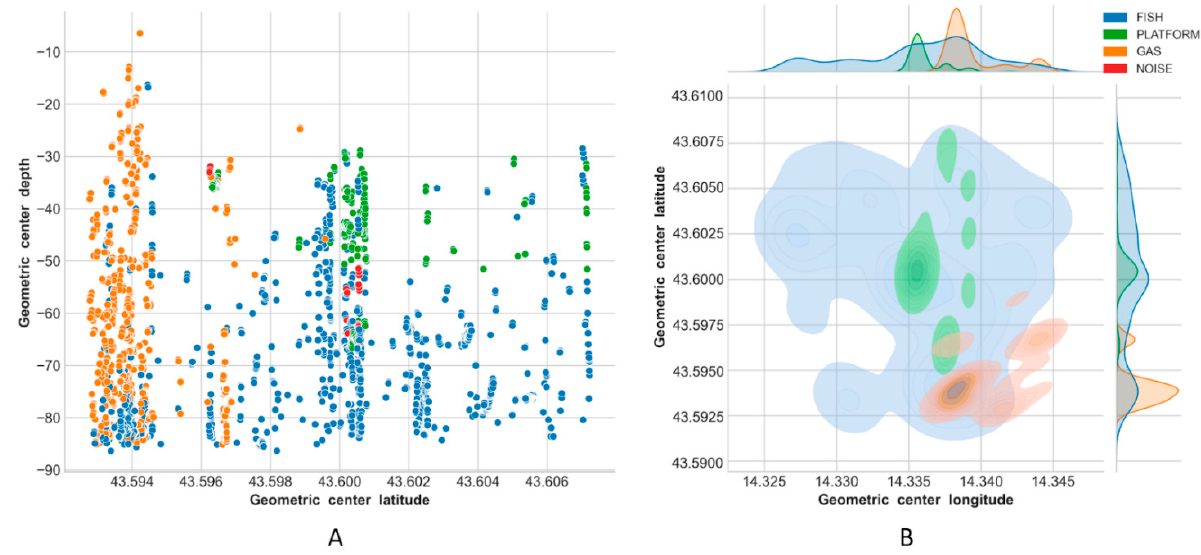
Sensors 2021 , 21 , x FOR PEER REVIEW Figure 14. Predictions on Survey 2: latitude-depth view ( A ), and Kernel Density Estimation plot (top view) ( B ).